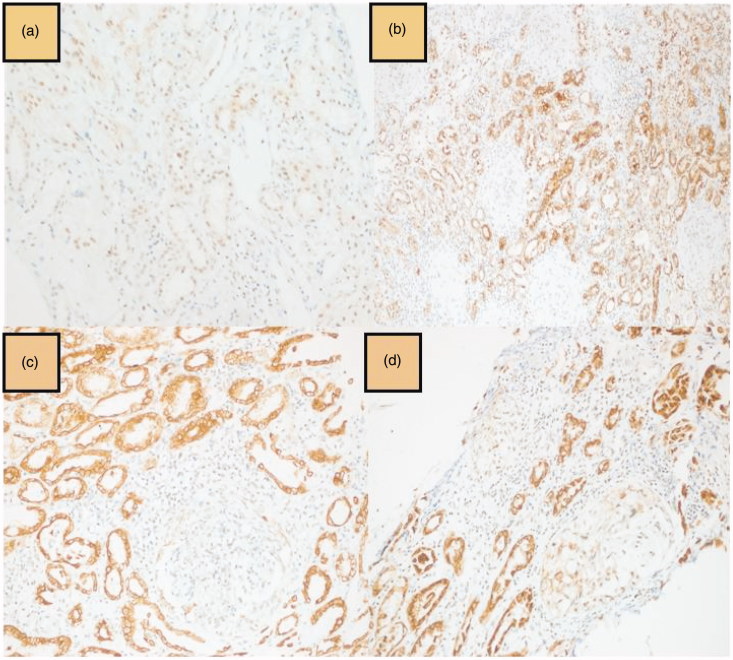
Tubulointerstitial and glomerular mTOR immunostaining; mild (a) and strong (b) tubulointerstitial mTOR positivity, and mild (c), and moderate (d) glomerular mTOR positivity.